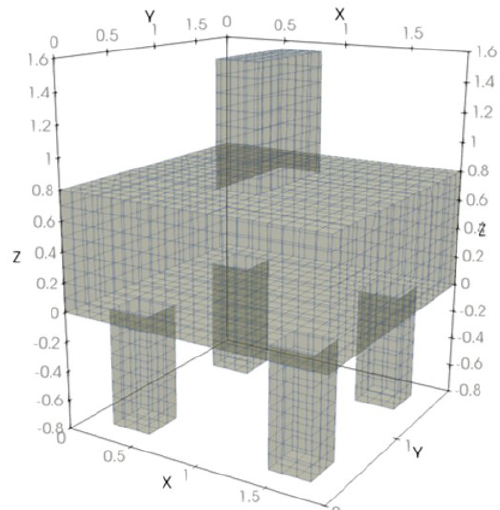
Figure 12. Structural solid model of a four-pile cap for the step 1 of the methodology